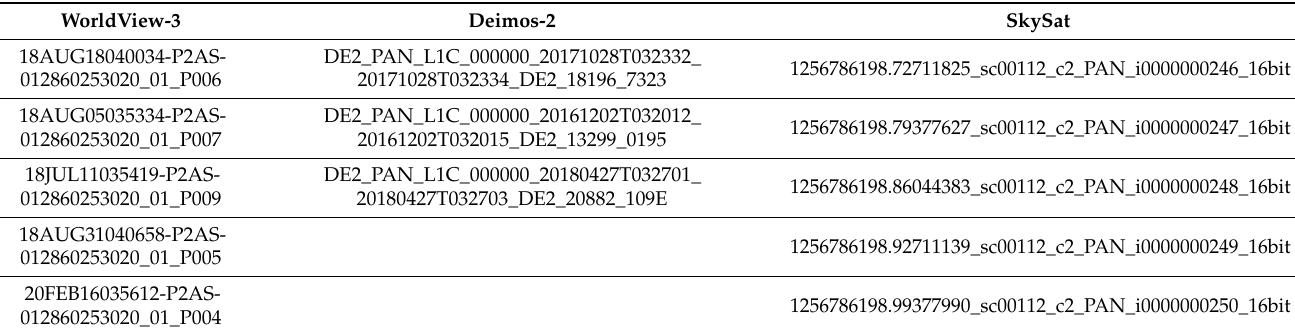
Table 1. Input image IDs for WorldView-3, Deimos-2 and SkySat image/video frames. The first row of the image IDs shows the reference image for multi-image SRR and sole-input for single-image SRR. WorldView-3 Maxar ® image 2020, provided by the European Space Agency; Deimos-2 ® : Deimos Imaging, S.L. in 2021; Skysat L1A imagery provided by Planet Labs,